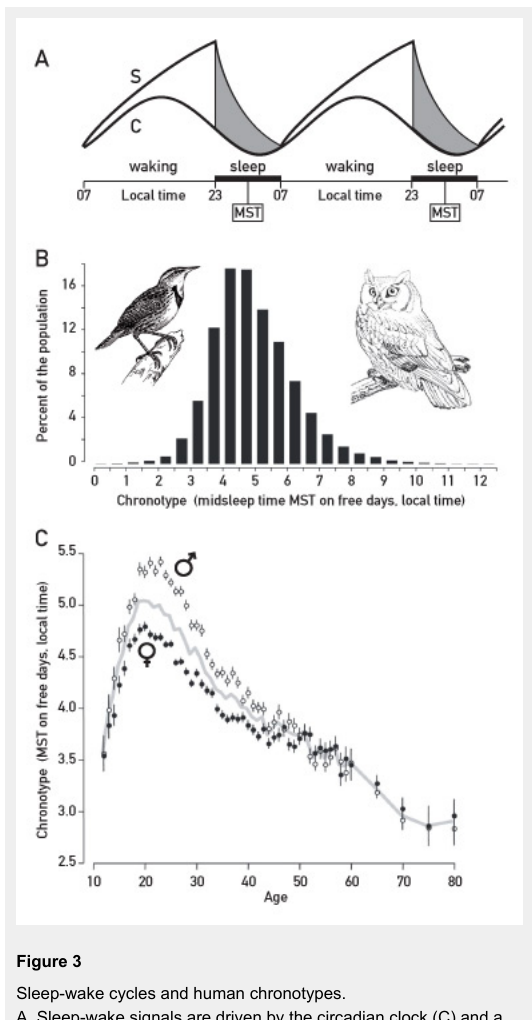
Sleep-wake cycles and human chronotypes. A. Sleep-wake signals are driven by the circadian clock (C) and a sleep homeostat (S). The sleep homeostat resembles an hourglass timer. Sleep pressure steadily builds up after waking until it is so strong that the individual falls asleep. While sleeping (grey zone / black bar on X-axis), sleep pressure diminishes back to the base level. The sleep homeostat is coupled to the circadian clock under normal conditions, but in some individuals the two time keepers can become disconnected from each other after having been exposed to an extended period without external time cues (see text). MST = midsleep time. This scheme was adapted from: Daan S, Beersma DG, Borbely AA. Timing of human sleep: recovery process gated by